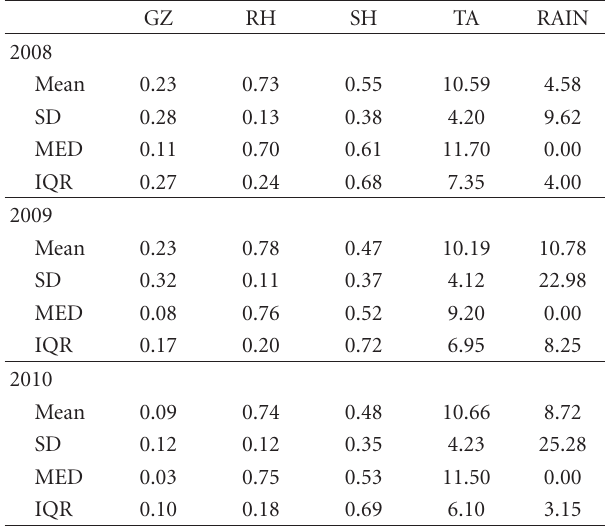
Table 1: Summary statistics from raw data observed from Septem- ber 15th to October 15th, during three years, in Passo Fundo, RS, Brazil. GZ TA